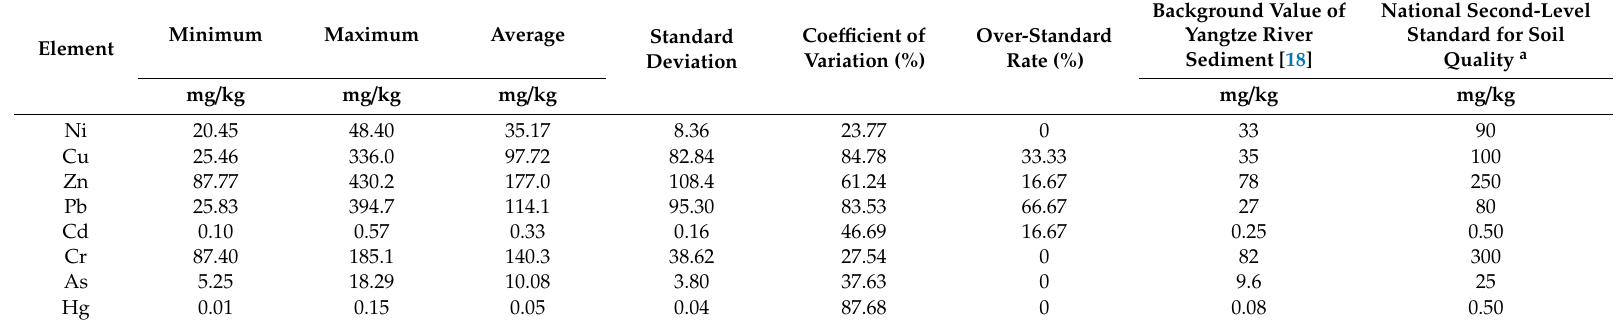
Table 3. Distribution of heavy metals in sediments of the Three Gorges